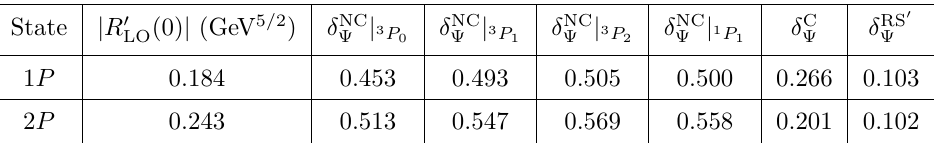
is the correction Ψ is the correction from Ψ